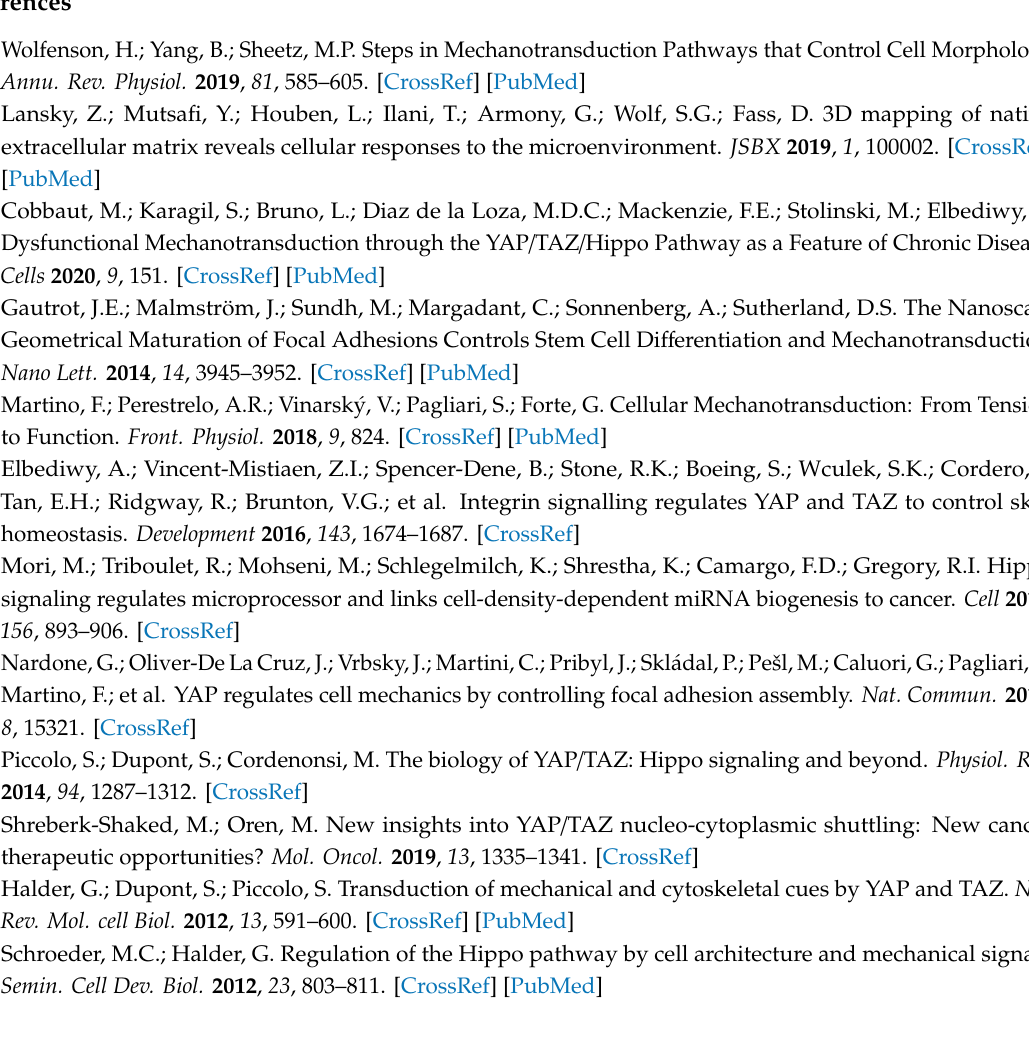
Figure S1: Examples of OEG SAM RGD-functionalization (A) and CB-based polymer brush RGD-functionalization (B) measured by SPR. Figure S2: Dependence of the RGD-immobilized level (given by SPR) on the volume concentration of RGD in a functionalization solution (A,B) and on the carboxy group content in the coatings (B,D). (A) 100% OEG-based SAM HS-(CH2)11-(EG)6-OCH2-COOH, (B) polymer brush of 100% pCBAA, (C) mixed OEG SAM of HS-(CH2)11-(EG)6-OCH2-COOH and HS-(CH2)11-(EG)4-OH, and (D) random copolymer brush of p(CBMAA-ran-HPMAA). Figure S3: Fouling level from undiluted human blood plasma after 10 min of exposure on RGD-functionalized surfaces. Figure S4: Cell death assessment on pCB antifouling RGD-functionalized coatings. Figure S5: Representative pictures from the spinning disk confocal microscope used for the cell growth assessment and images of YAP distributions in cells growing on a CB-containing antifouling background decorated with di ff erent RGD peptide